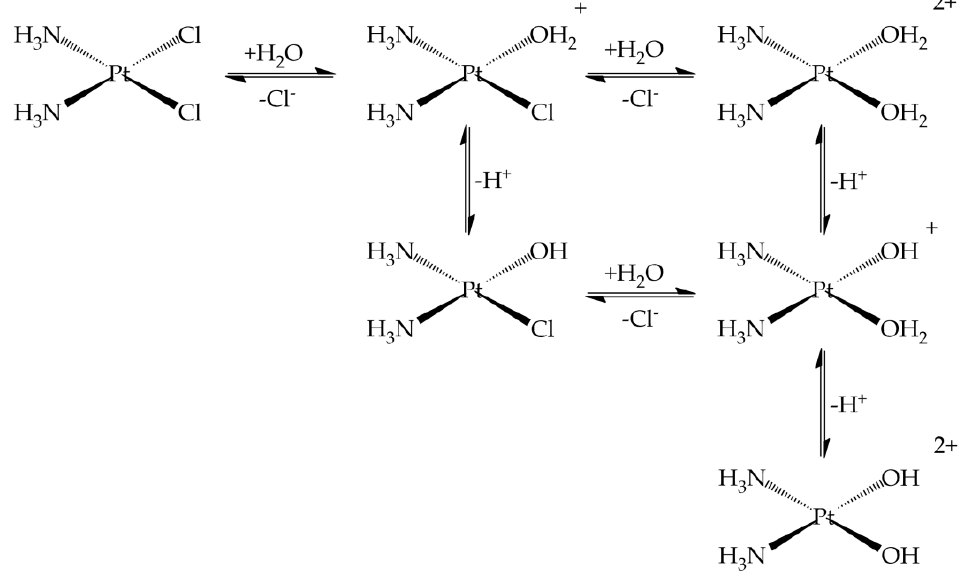
Figure 3. Ligand substitution (chloride) and protonation equilibria for cisplatin.